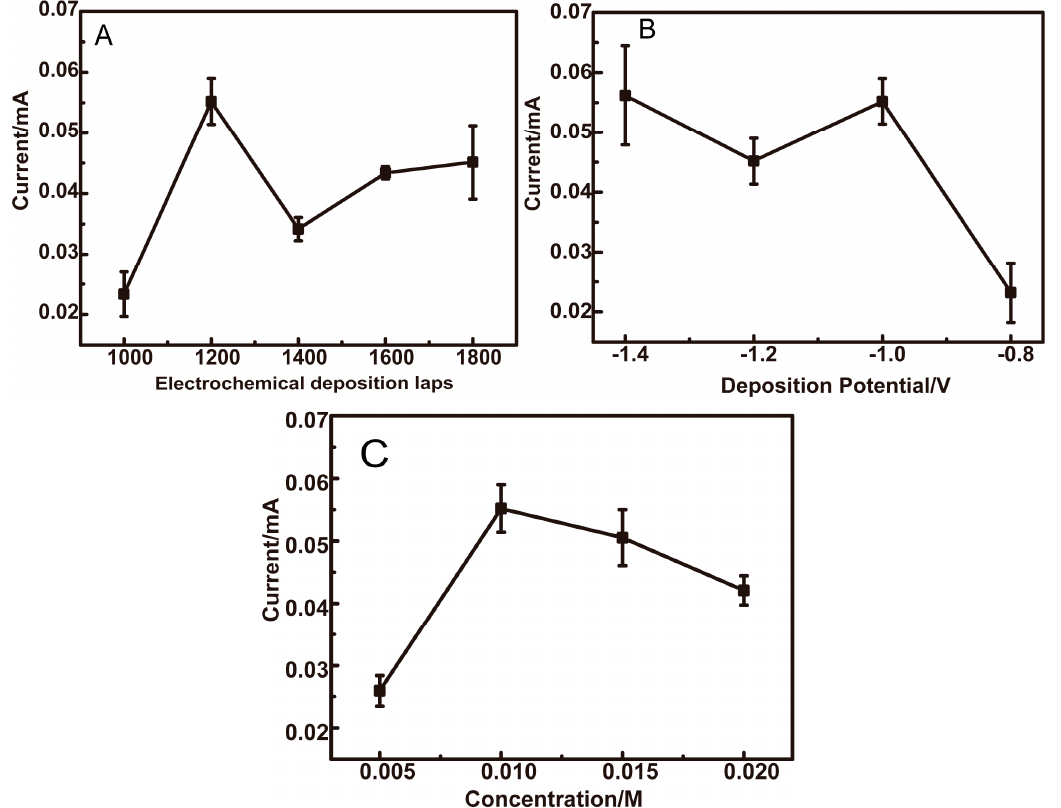
Figure 5. i-t of CuO/PCL@PPy/ITO electrode in 0.01 M NaOH solution containing 0.1 mM glucose ( A ) different electrochemical deposition laps; ( B ) different deposition potentials; ( C ) varying concentrations of CuSO 4 solution.